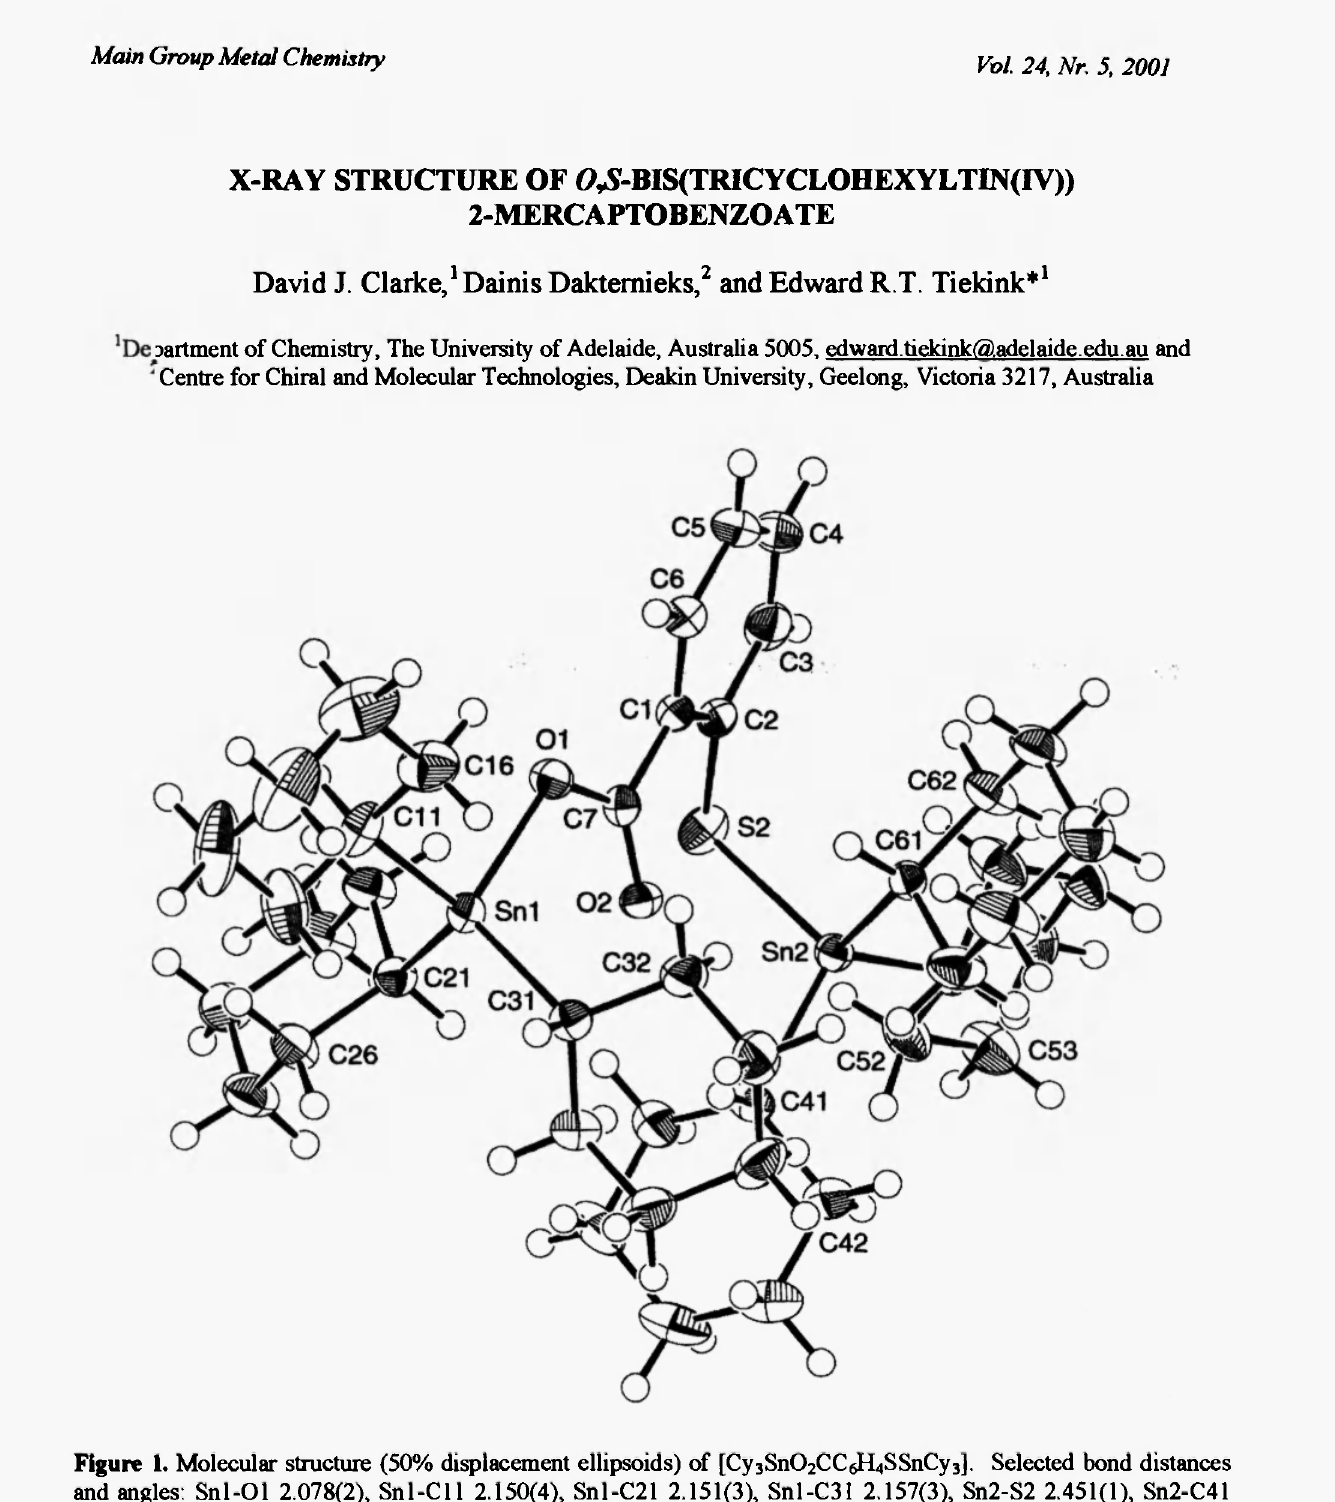
Figure 1. Molecular structure (50% displacement ellipsoids) of [Cy and angles: Snl-0 1 2.078(2), Snl-Cll 2.150(4), Snl-C21 2.151(3), Snl-C31 2.157(3), Sn2-S2 2.451(1),